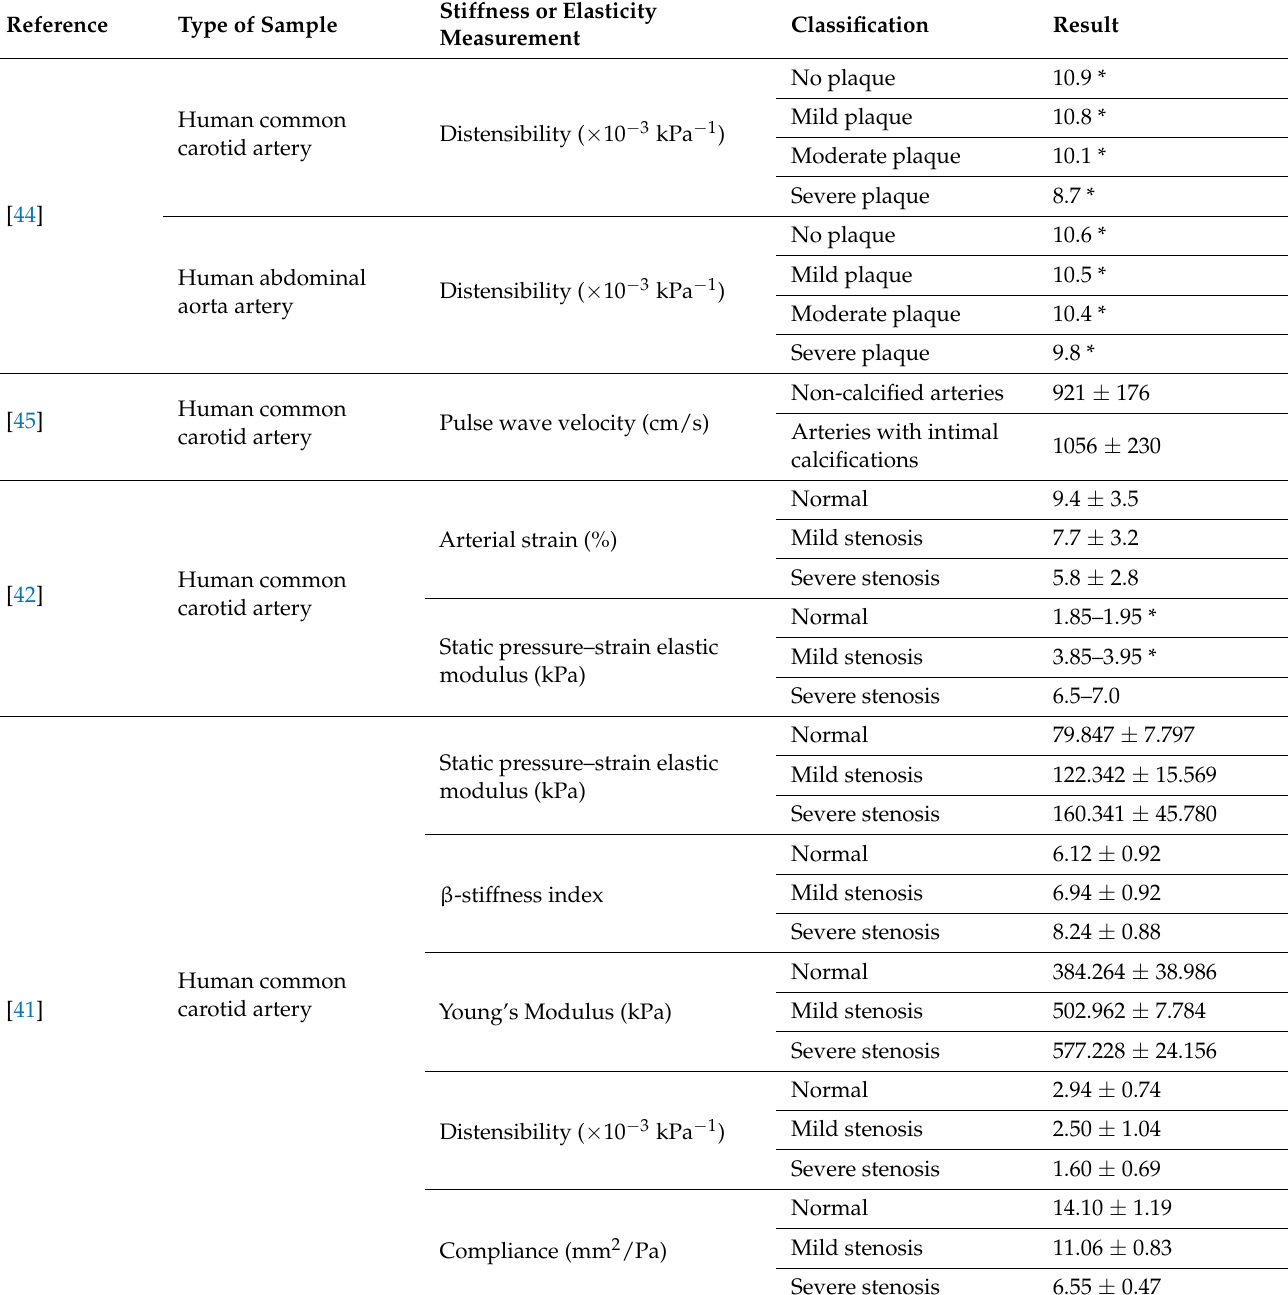
Table 3. Results of studies investigating arterial stiffness in atherosclerotic vessels, from dynamic arterial changes